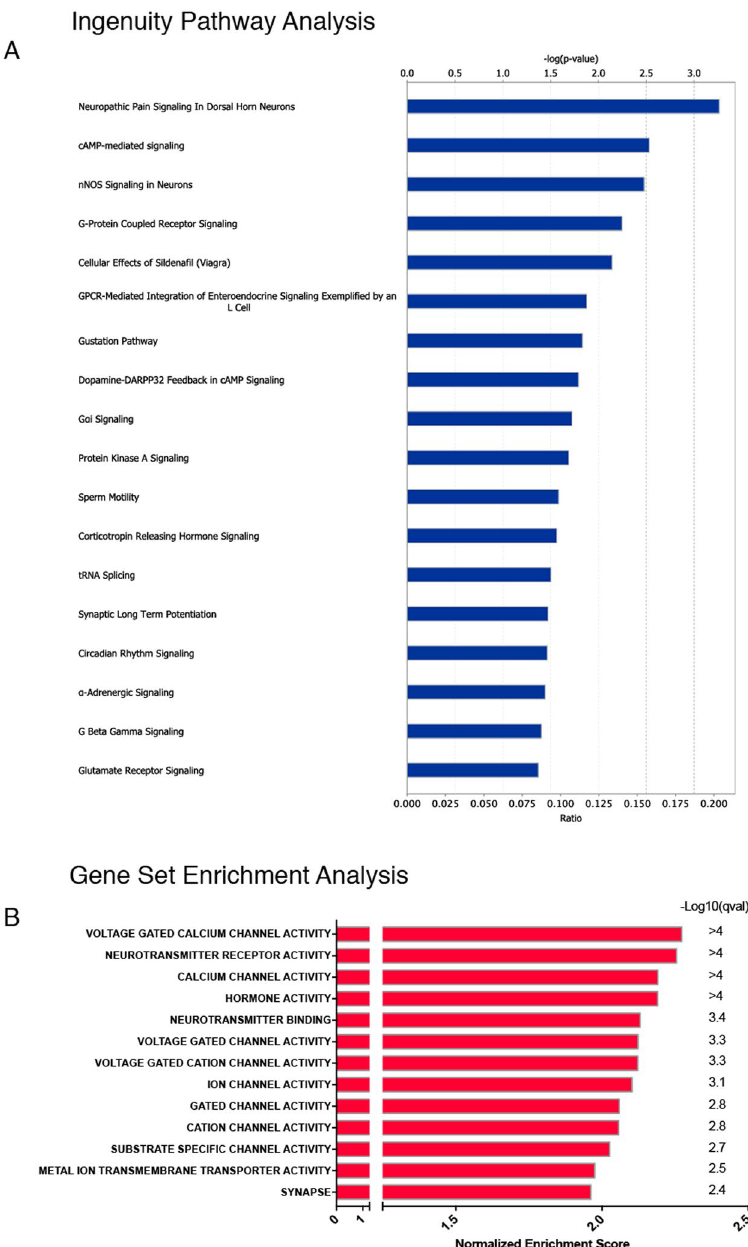
Figure 5. Pathway analysis and Gene Set Enrichment Analysis of SST neurons. ( A ) Ingenuity Pathway Analysis reveals multiple enriched pathways in SST neurons. Top axis = − log(p-value). Bottom axis = ratio of enrichment in canonical pathway. Data were analyzed through the use of IPA (QIAGEN Inc., https://www. qiagenbioinformatics.com/products/ingenuitypathway-analysis). ( B ) Gene Set Enrichment Analysis of SST